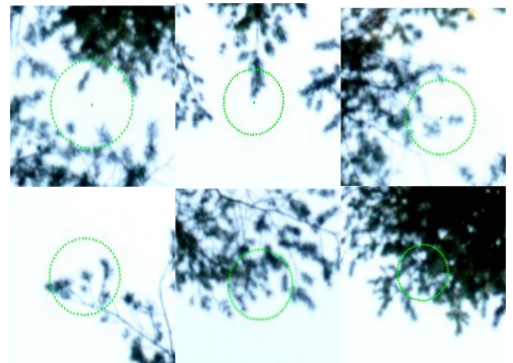
Figure 7. Examples of LMS-Q680i (1/e 2 ) first-echo footprints in pine crowns, showing an intensity gradient with DN values of 10, 15, 26, 37, 46, and 89. The largest value is associated to a single echo, while the rest are of type first-of-many.